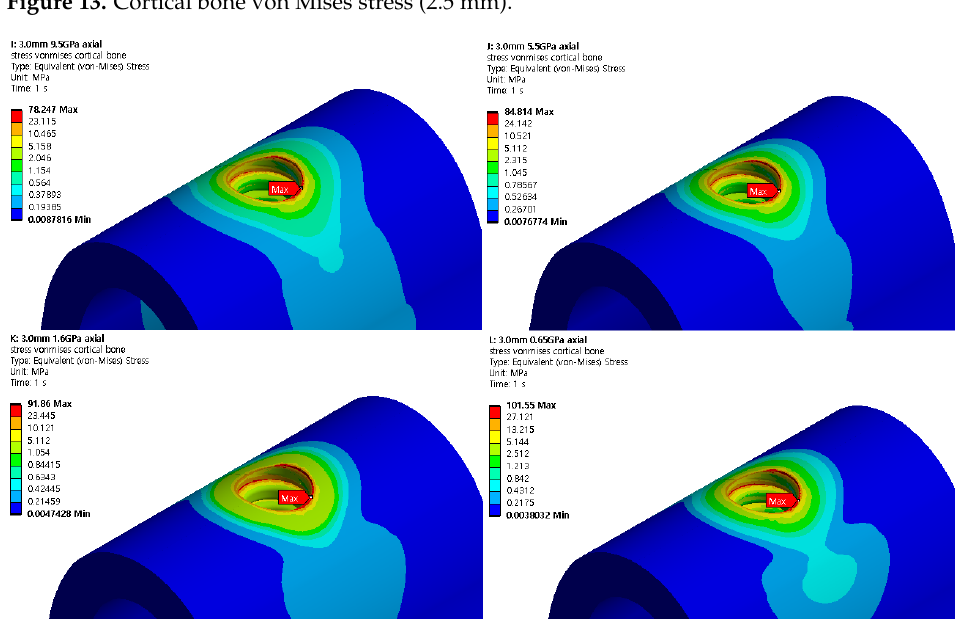
Figure 13. Cortical bone von Mises stress (2.5 mm).